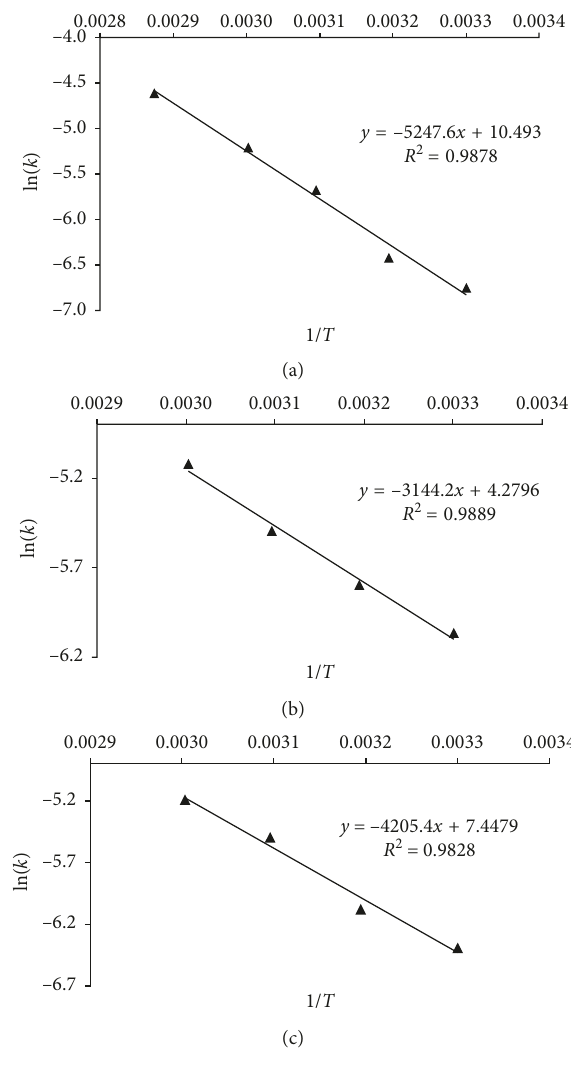
Figure 5: Arrhenius plot for the hydrolysis of c -oryzanol (A20) by the heating method and ultrasonic irradiations. (a) Heating method. (b) 20kHz ultrasonic irradiation. (c) 200 kHz ultrasonic